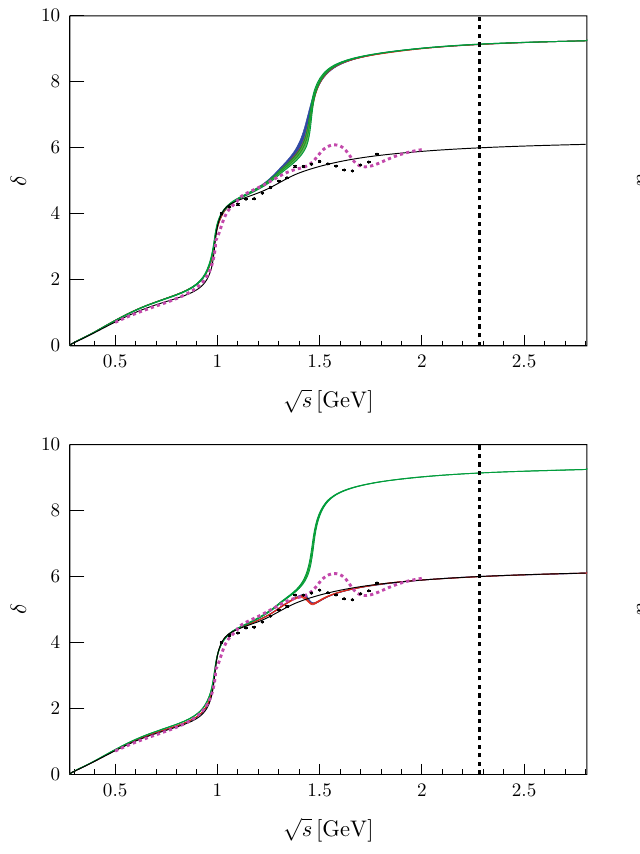
Fig. 9 Scalar isoscalar pion–pion scattering phase shift δ (left) and inelasticity η (right) defined by the ππ S -wave amplitude T 11 = (cid:19) (cid:20) η e 2 i δ − 1 /( 2 i σ π ) for the fits with an additional ρρ (top) and σσ (bottom) channel. Fit 1 is shown in blue, Fit 2 in red, Fit 3 in green,